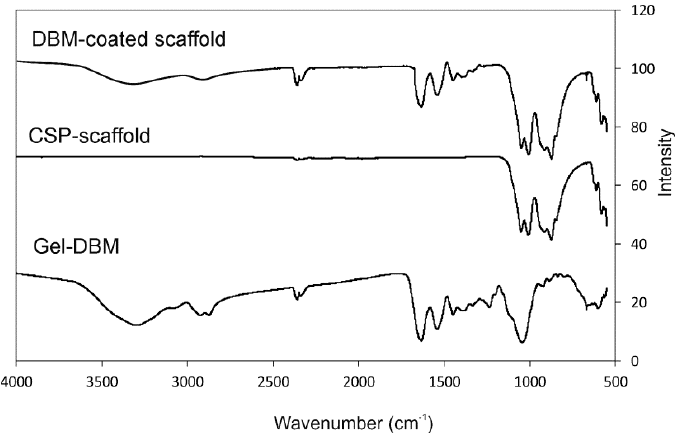
Figure 6. The FTIR of the CSP scaffold, the DBM-coated scaffold, and gel DBM for comparison